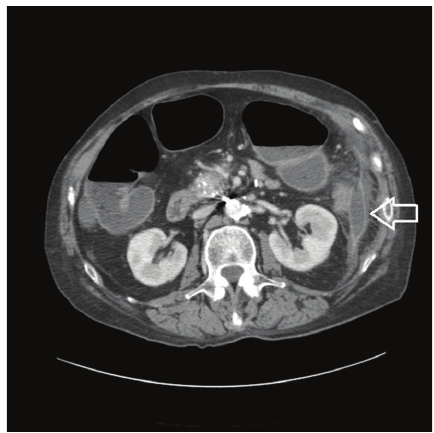
Figure 3: CT abdomen/pelvis done at outside hospital at time of admission showing fluid collection around the pancreatic tail and splenic flexure 4.7 cm.